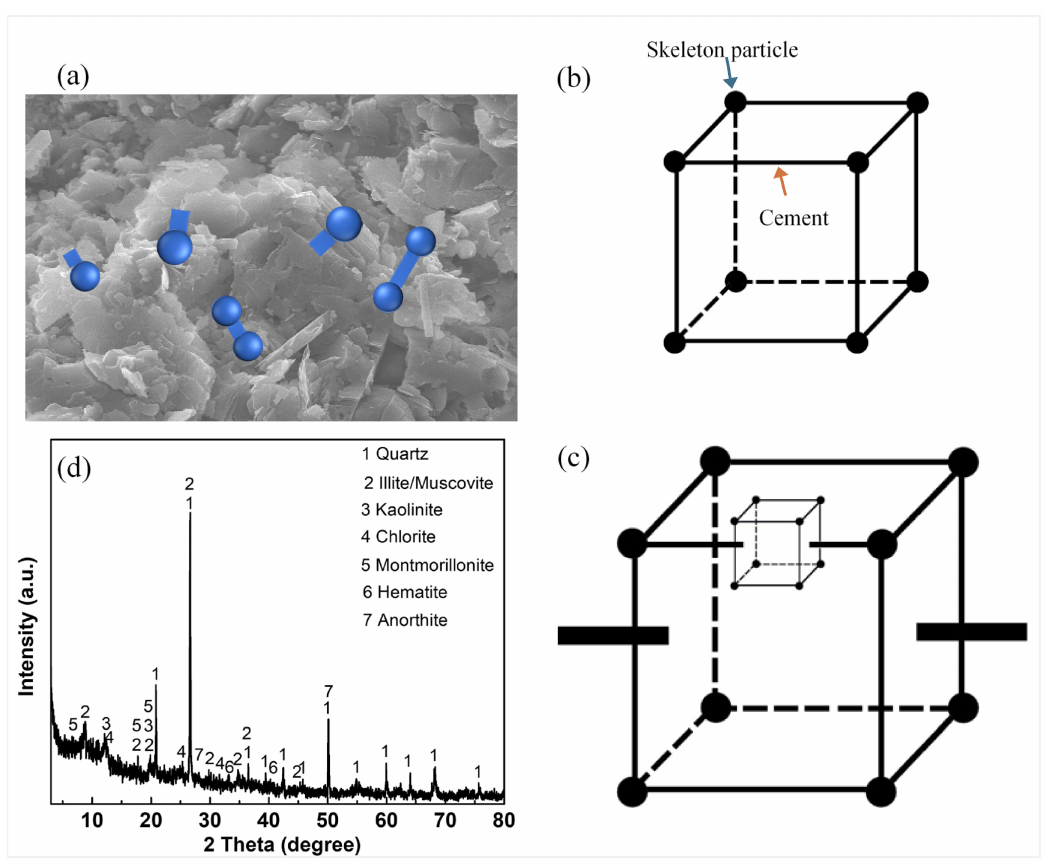
Figure 2. Microstructure and renormalization model of soft rock: ( a ) silty mudstone microstructure, ( b ) renormalized model unit of soft rock, ( c ) renormalization model of soft rock, ( d ) the XRD chart of soft